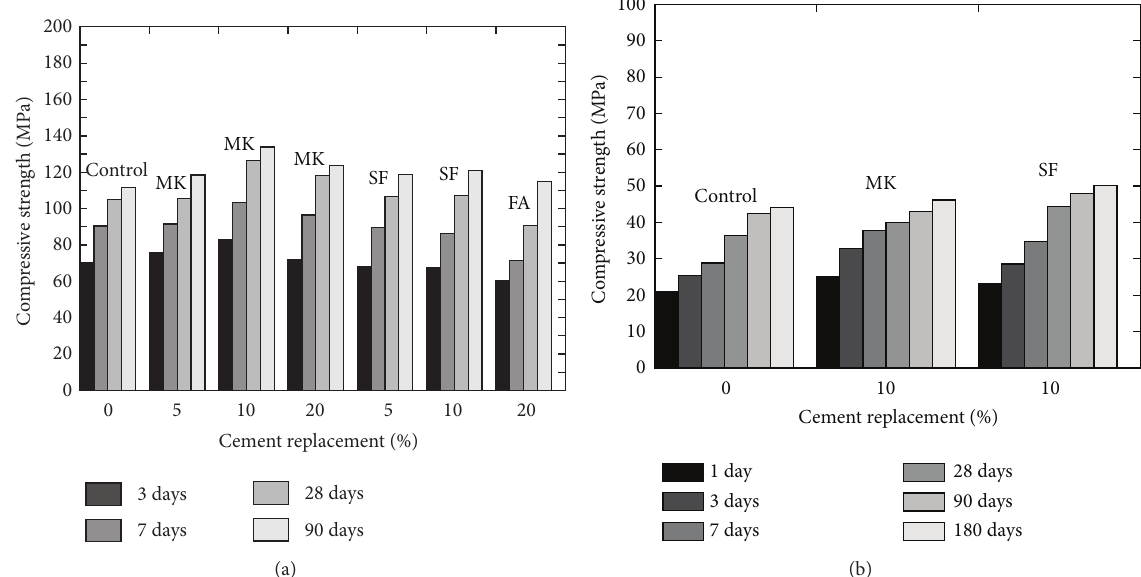
Figure 11: Effect of cement replacement on the compressive strength of (a) MK pastes compared to SF and FA pastes (w / b = 0.3 ) [12] and (b) MK concrete compared to SF concrete (w / b = 0.4 ) [30].